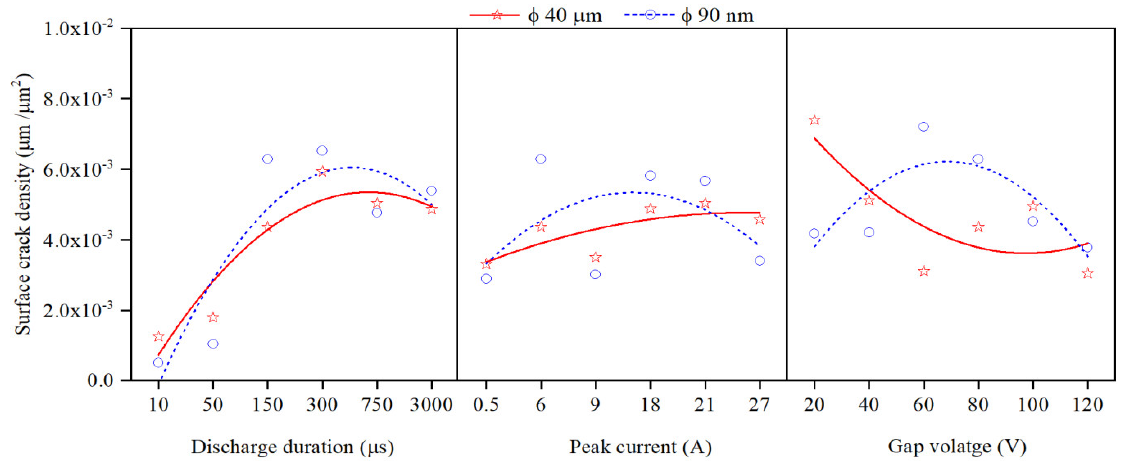
Figure 14. Effect of input process parameters on surface crack density.